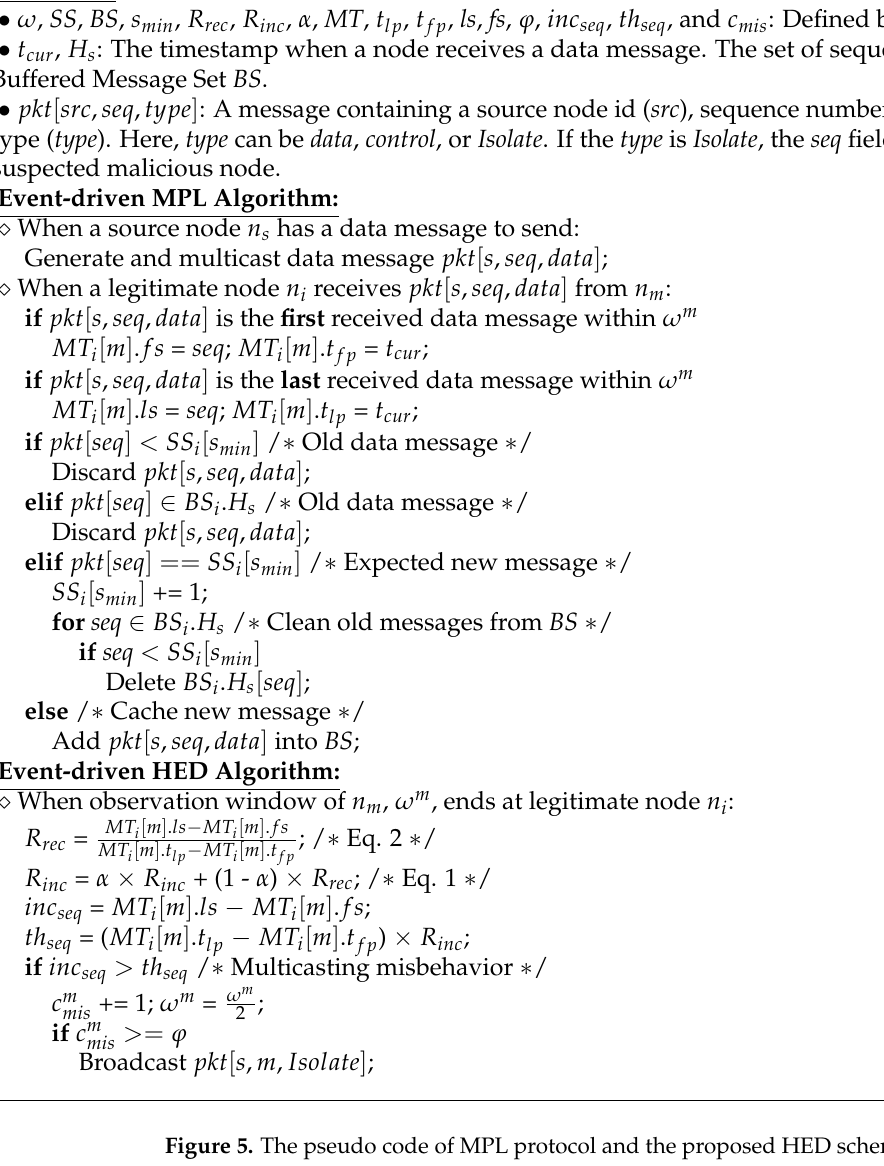
Figure 5. The pseudo code of MPL protocol and the proposed HED